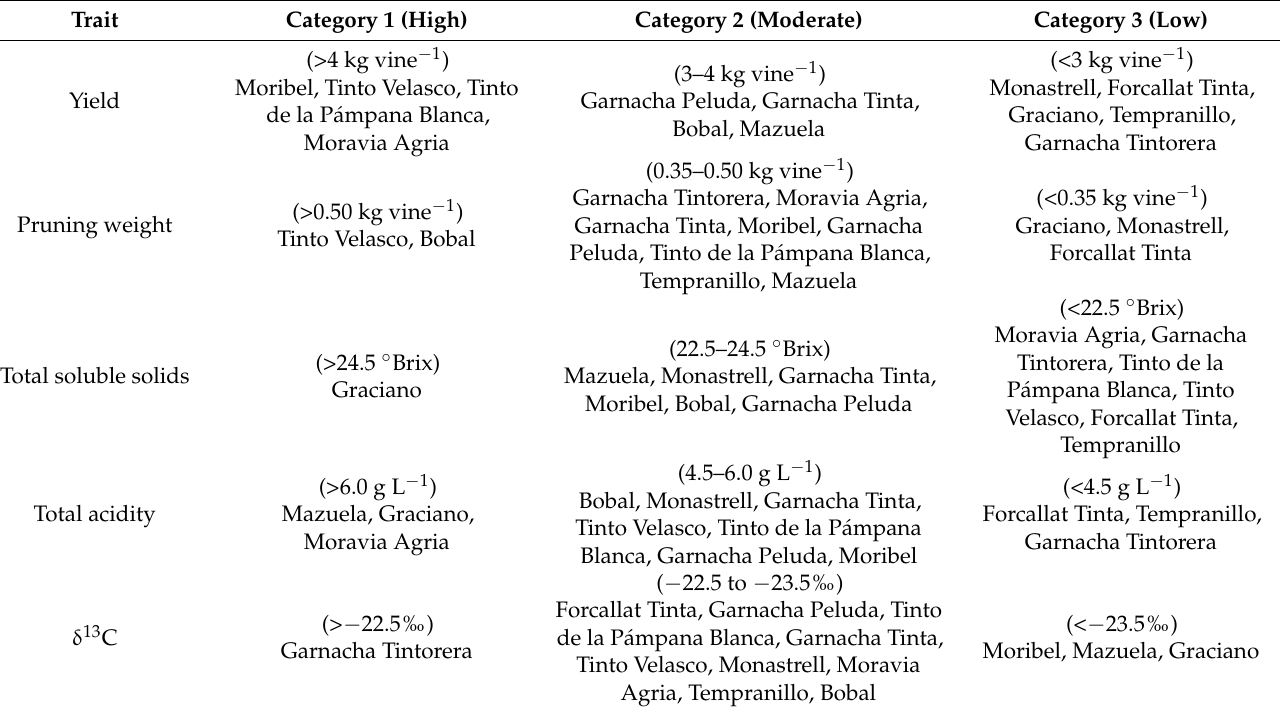
Table 3. A synthesis of the study results categorizes the cultivar’s drought tolerance according to five traits: yield, pruning weight, total soluble solids, total acidity, and δ 13 C. Category cut-offs are arbitrarily chosen (adapted from